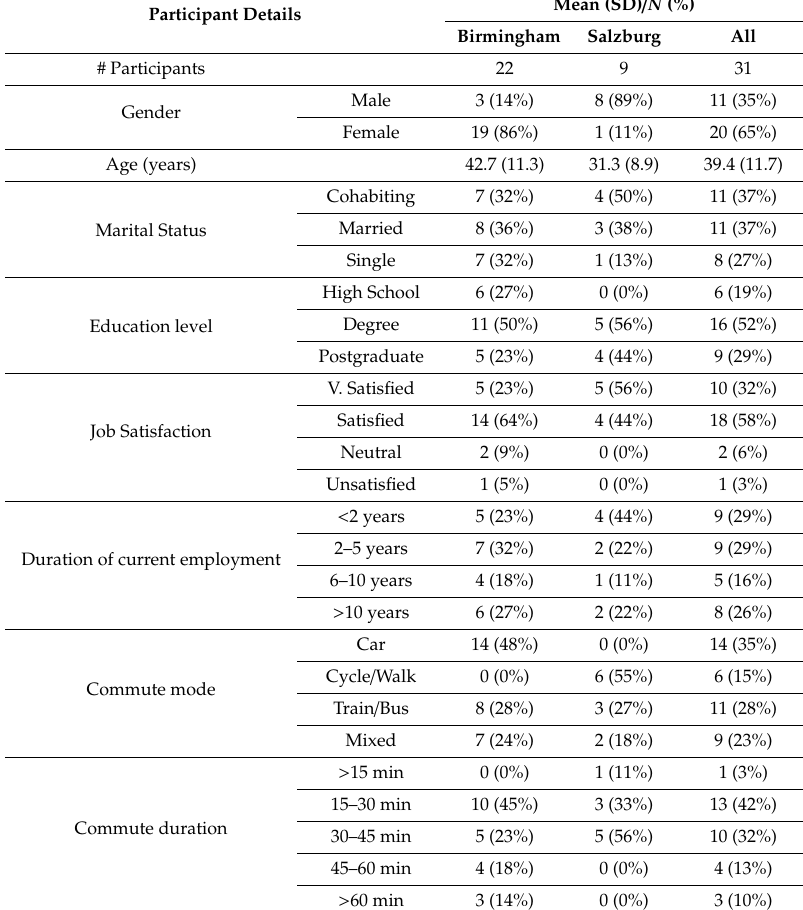
Table 1. Description of study